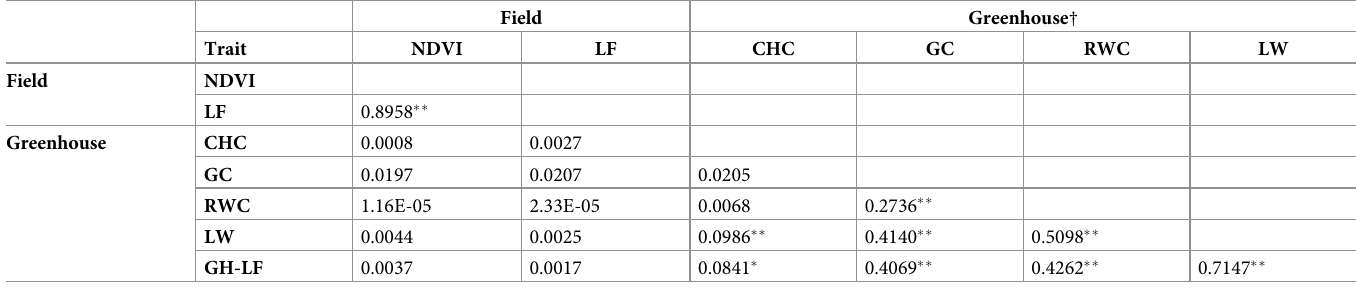
Table 2. Correlation coefficients among chlorophyll content (CHC), green cover percent (GC), leaf relative water content (RWC), leaf wilting (LW), leaf firing (LF) and normalized difference vegetation index (NDVI) for a St. Augustinegrass Raleigh x Seville F 1 population evaluated for drought response under greenhouse and field